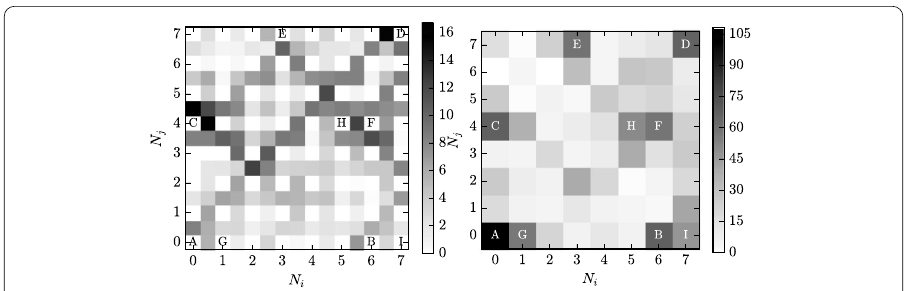
Figure 6 Results of the SOM applied to Project Gutenberg books. Left panel: Nodes on the 2D SOM grid are shaded by the number of stories for which they are the winner. Right panel: The B-matrix shows that there are clear clusters of stories in the 2D space imposed by the SOM